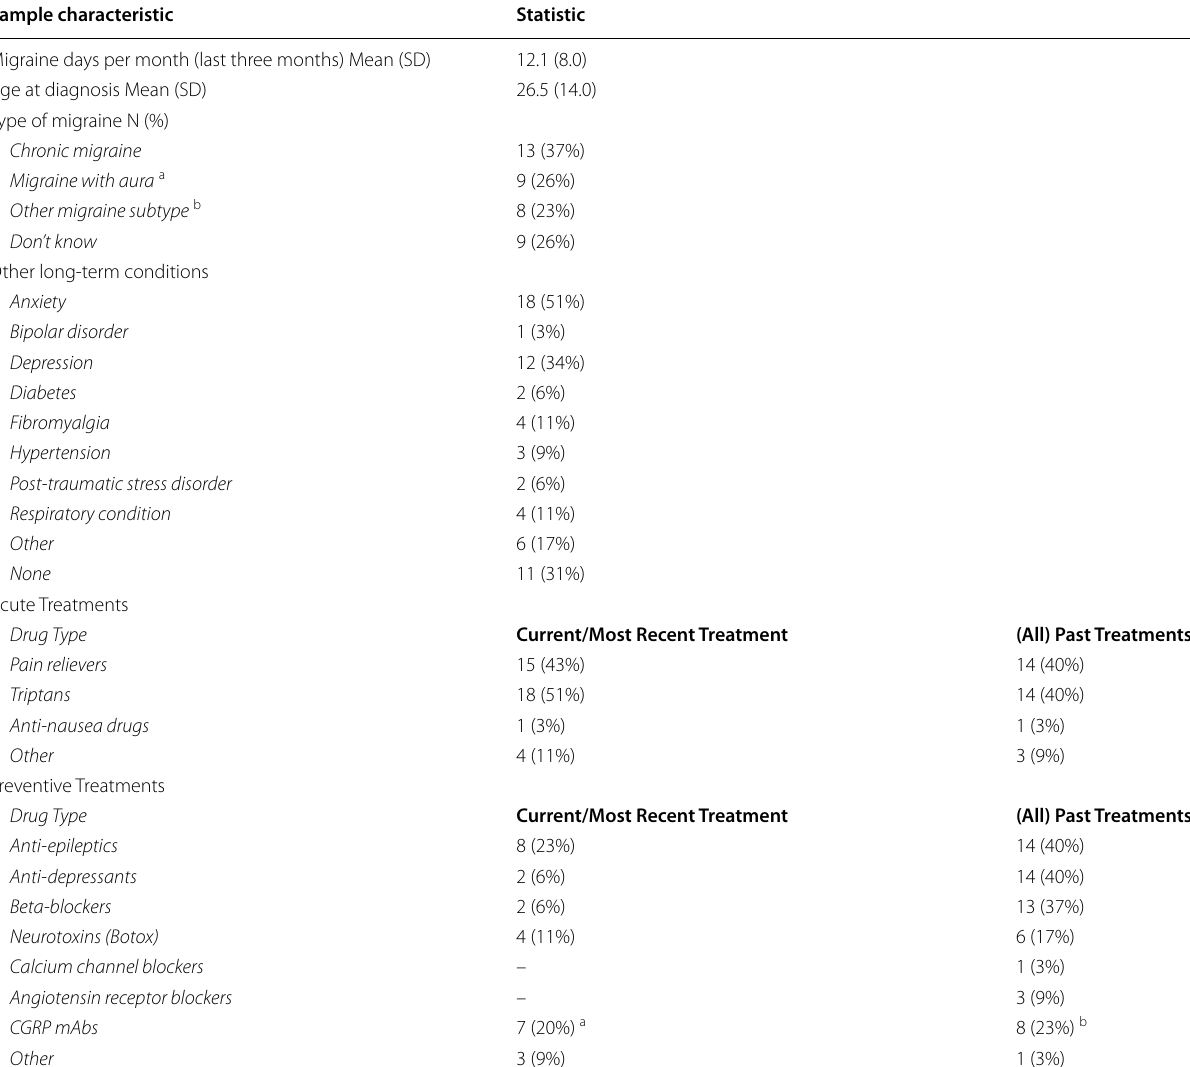
Table 2 Study sample clinical characteristics ( n